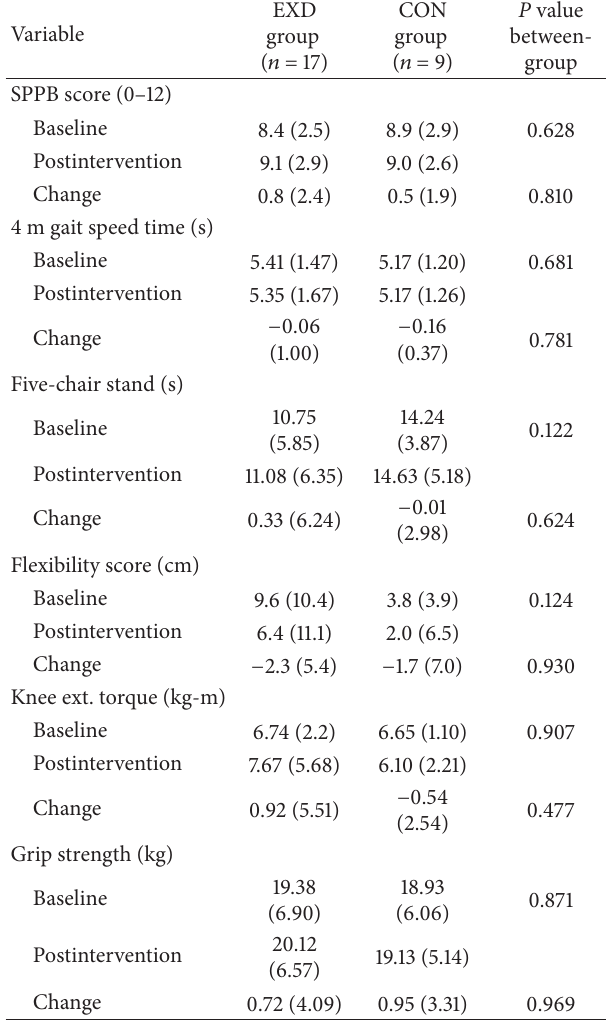
The EXD group improved flexibility by 2.3 (5.4) cm with the 12-week intervention ( 𝑃 = 0.07); however, no significant changes occurred with the 12-week intervention. Ext.: